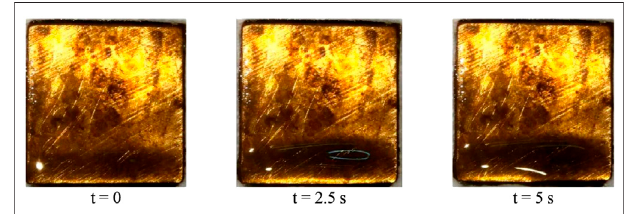
FIGURE 6 | Film condensation process in a gas-steam mixture (within a slip cycle).